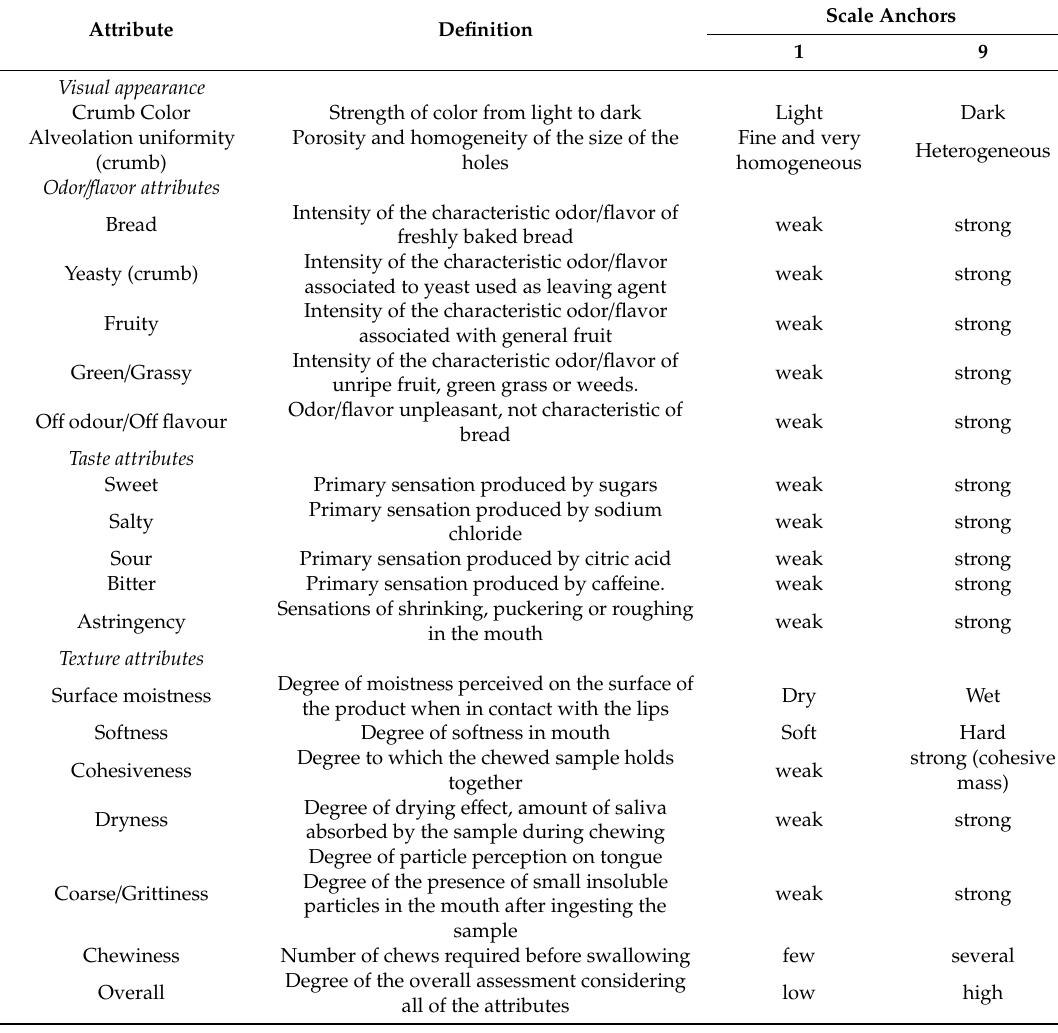
Table 1. Sensory attributes, definition and anchors used in the descriptive analysis of bread